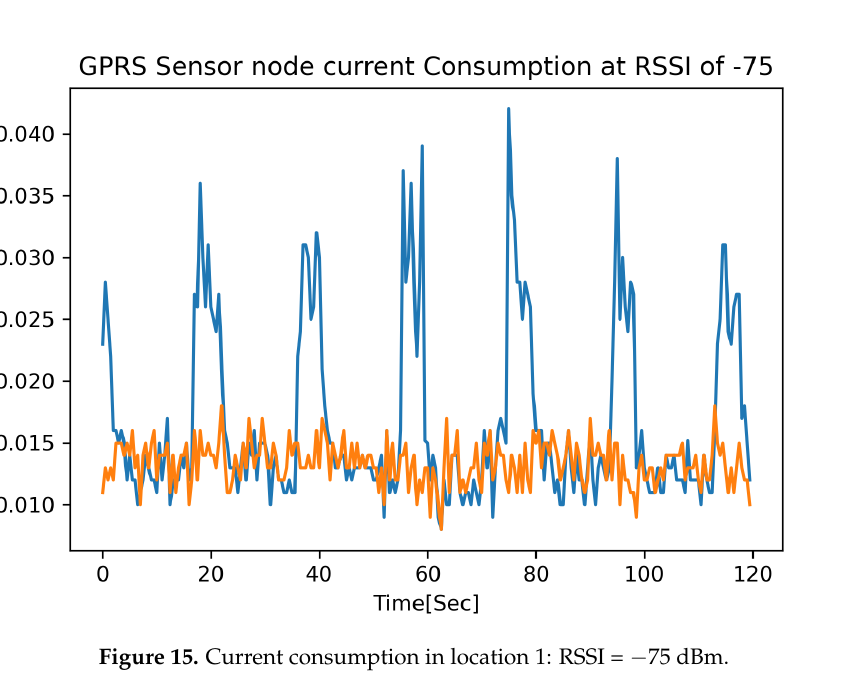
Figure 15. Current consumption in location 1: RSSI = − 75 dBm.